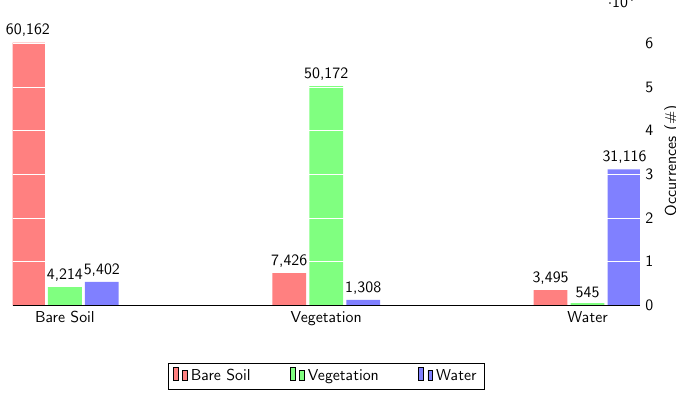
Figure 6. Bar plot of the Confusion